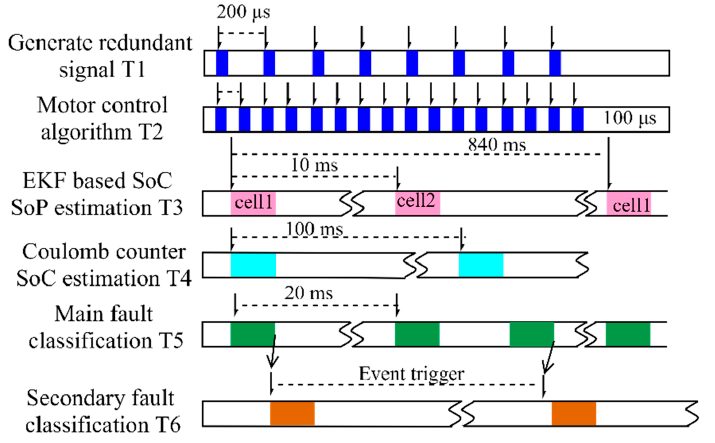
Figure 11. Task execution chart.